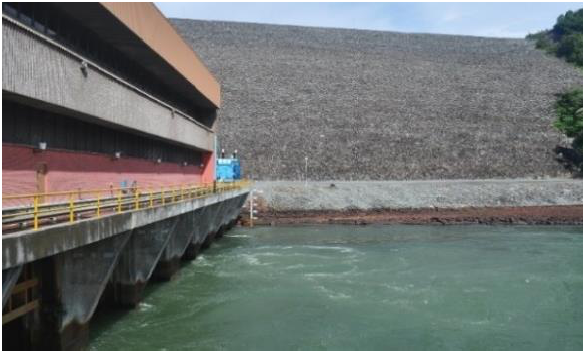
Figure 2. Downstream of Temenggor dam with outlet of the power-station.